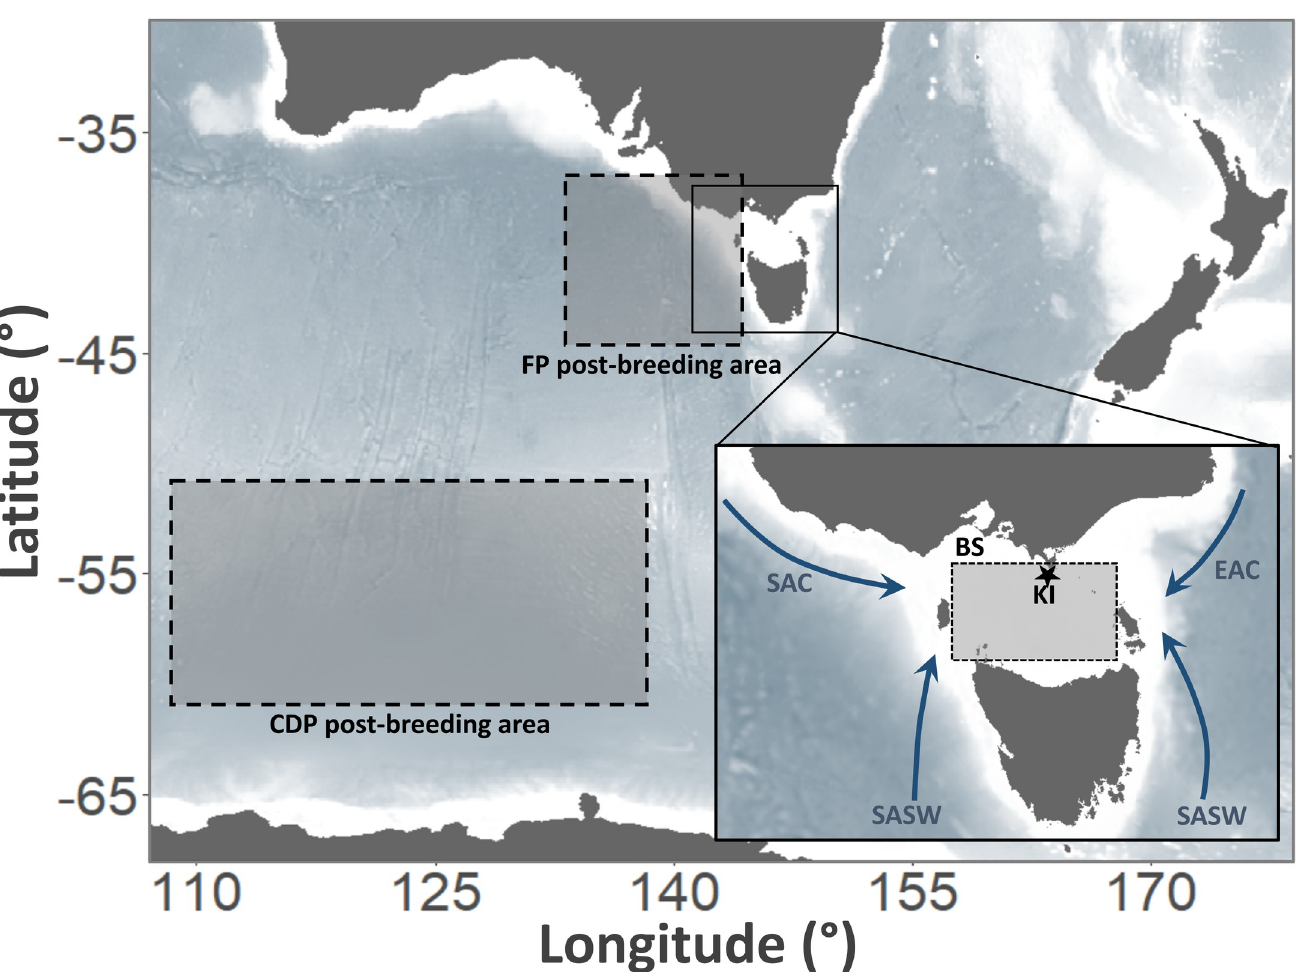
Fig 1. Study area of fairy prions ( Pachyptila turtur ) and common diving petrels ( Pelecanoides urinatrix ) from Kanowna Island, Bass Strait, south-eastern Australia. The lower right panel shows the main water masses influencing Bass Strait: Kanowna Island (KI); South Australian Current (SAC); Sub-Antarctic Surface Water (SASW); East Australian Current (EAC). The shaded rectangles describe the areas for which seasonal sea surface temperature was extracted: Bass Strait (BS; study breeding region; Fromant et al. unpublished data); post-breeding area of fairy prion (FP Post-breeding area; Fromant et al. unpublished data); post-breeding area of common diving petrels (CDP post-breeding area;